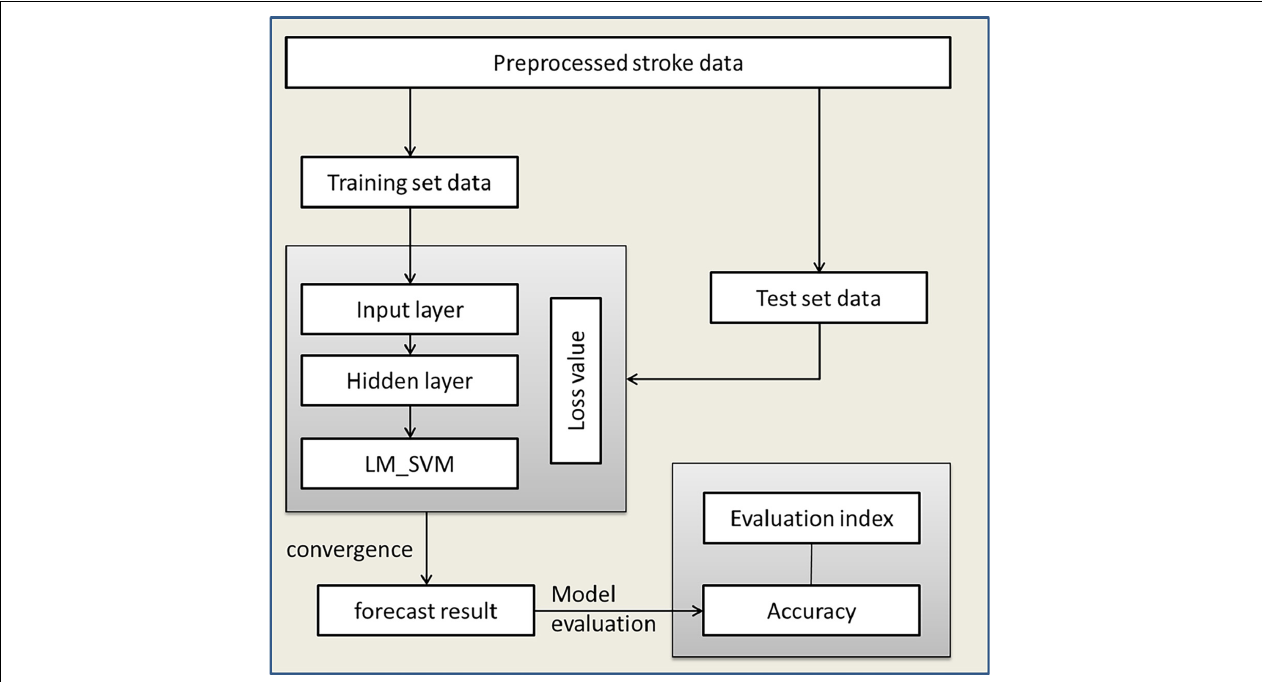
FIGURE 3 | Rehabilitation model execution